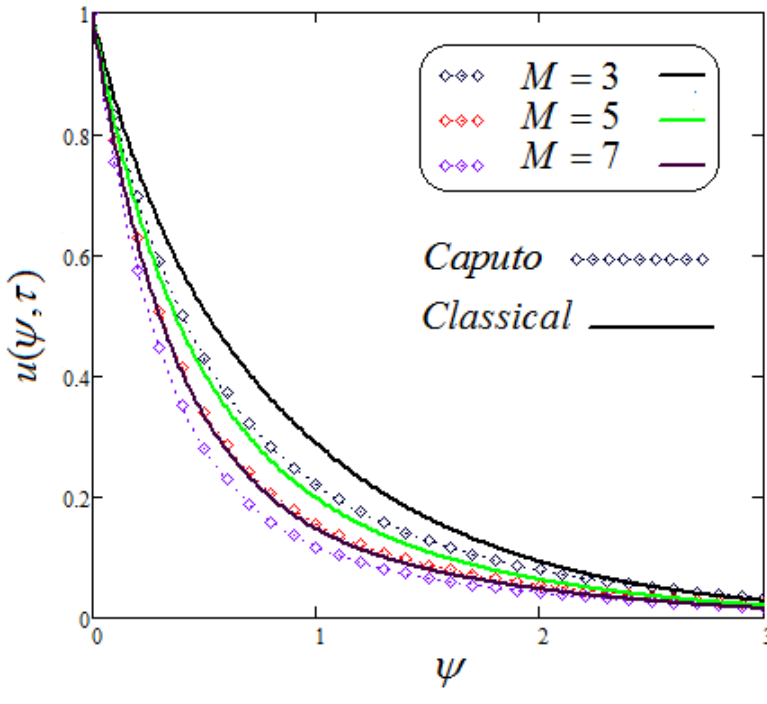
Figure 13. Trace of velocity comparison for dissimilar values of M .